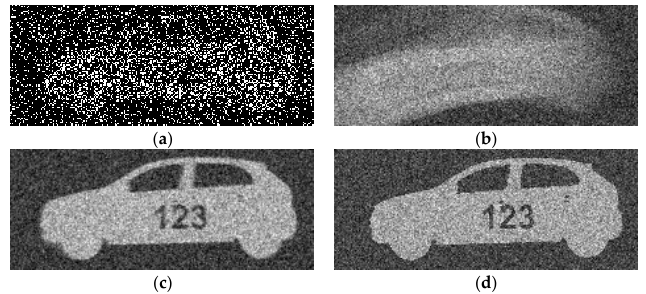
Figure 6. Results for synthetic data with H car = 0.35 and H back = 0.15: ( a ) Single bit-plane ( i = 1); ( b ) Sum of bit-planes ( i = 1, …, 72) of moving car; ( c ) Reconstructed image of moving car ( R = 0.926); ( d ) Sum of bit-planes for still car. All images show a region of interest of 230 × 90 from the full 400 × 240 array size.